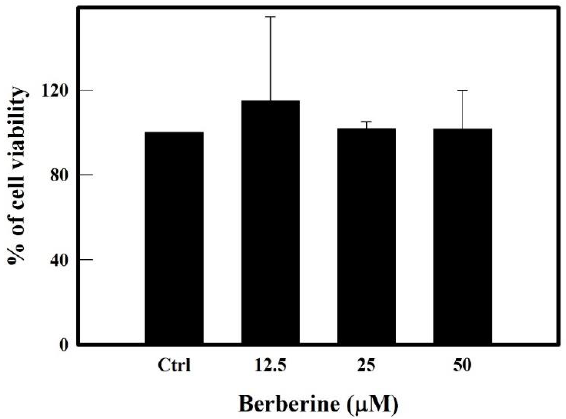
Figure 1. MTT assay of berberine treated THP-1 cells. Cell viability after treating with different concentrations of BBR ranging from 0 to 50 μM for 16 h at 37 °C and 5% CO 2 was checked by MTT assay. Samples of media alone (without cells) incubated with BBR were used as respective blanks. Ctrl (control) represents cells treated with media alone without berberine. Data represent mean ± SD of three independent